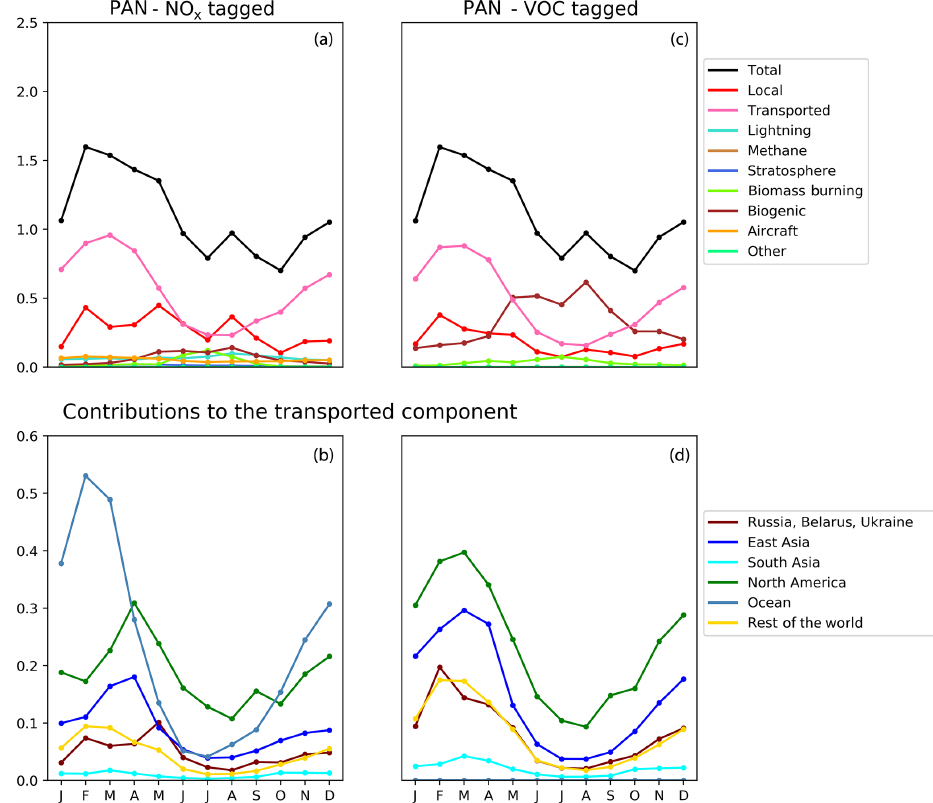
Figure 8. Seasonal cycle of column-integrated lower tropospheric PAN (10 − 15 molec.cm − 2 ) in the HTAP Tier 2 receptor region “North West Europe”. The lower troposphere is defined here as all model levels between 800 and 500hPa. NO x tagging is shown in panels (a) and (b) , and reactive carbon tagging is shown in panels (c) and (d) . Panels (a) and (c) show the total monthly mean PAN (black line) as well as the local anthropogenic component, the long-range transported anthropogenic component, and the natural components. Panels (b) and (d) show the individual Tier 1 source regions responsible for the long-range transported component of